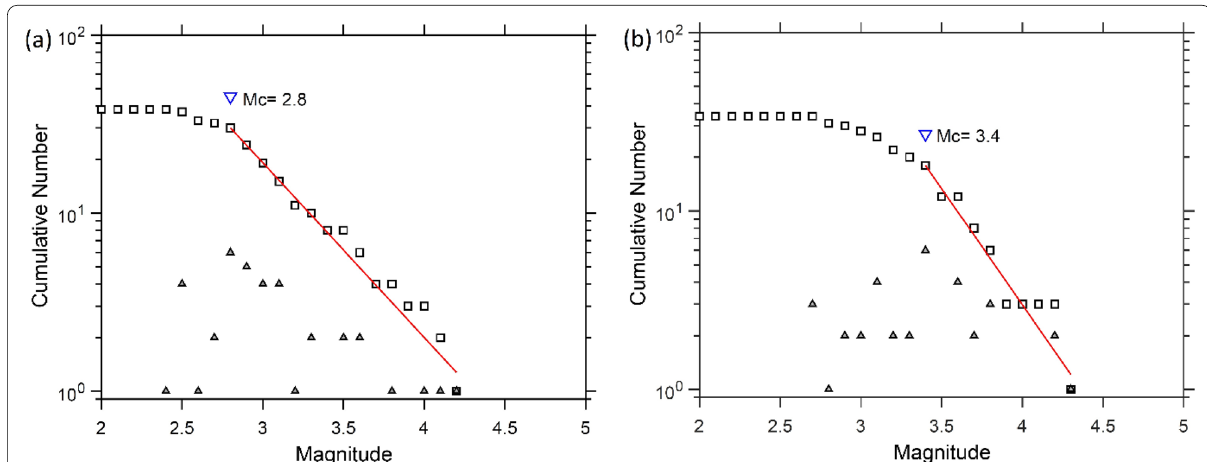
Fig. 6 Earthquake magnitude–frequency relation (Gutenberg–Richter law) for earthquakes that occurred within the blue rectangle shown in Fig. 7a, and were recorded during the same period by a borehole stations and b BMKG stations. The triangles and squares in the plot depict data and cumulative number of the data,